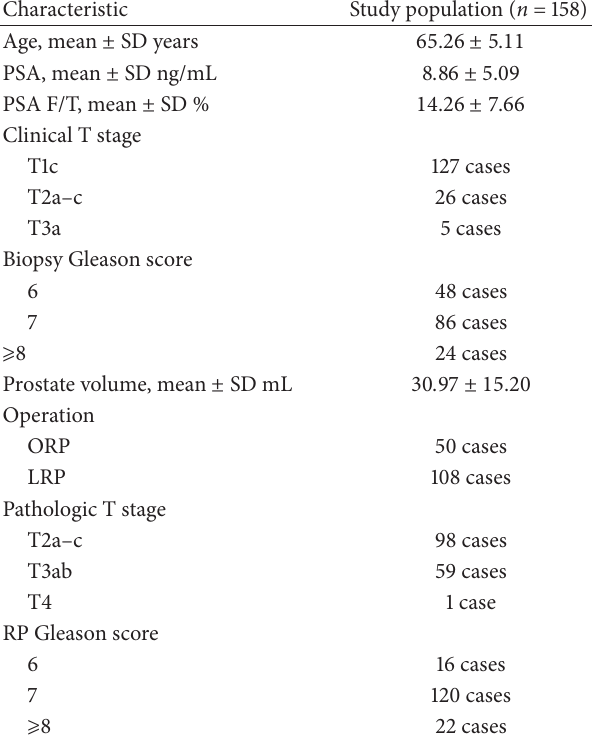
Table 1: Patients’